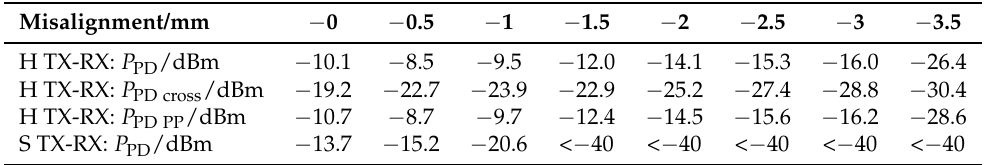
Table 3. Minimum P PD depending on the misalignment in negative x-direction ( y = 0). Values are determined by choosing the minimum value P PD on a circle around the center with a radius of the misalignment. Values lower than 40dBm are very noisy due to the finite number of simulated rays.